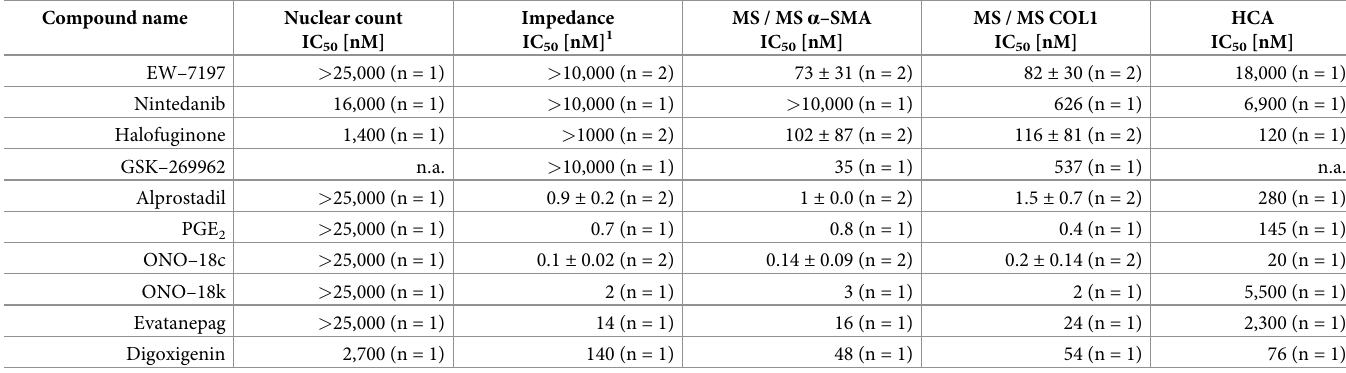
Table 4. IC 50 values of selected compounds in the NHLF myofibroblast reversal